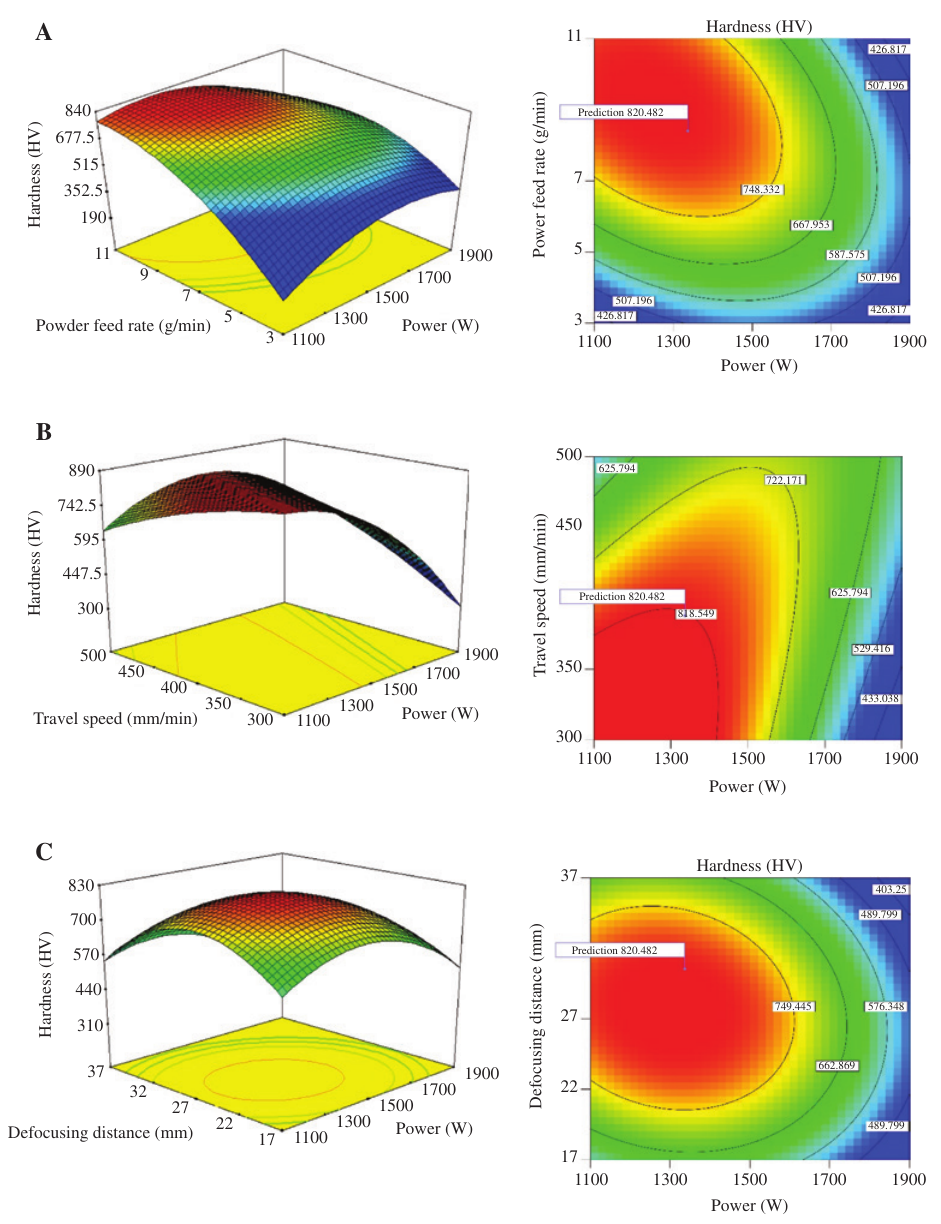
Figure 6: Response surface graphs and contour plots. (A) Interaction effect of power and powder feed rate. (B) Interaction effect of power and travel speed. (C) Interaction effect of power and defocusing distance. (D) Interaction effect of powder feed rate and travel speed. (E) Interaction effect of powder feed rate and defocusing distance. (F) Interaction effect of travel speed and defocusing